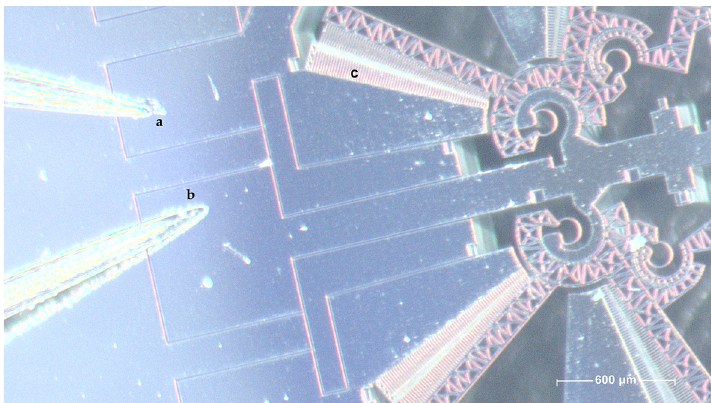
Figure 2. The two micropositioners with probe arms and tungsten needles ( a ) and ( b ), used in both the experimental setups; a voltage is applied to the comb-drive ( c ) of the DUT, in order to supply the device. Two micropositioners with 5 µ m resolution have been used, each one being equipped with tungsten needles, in order to apply the voltage to the DUT electrodes, Figure 3, and a set of digital images have been acquired using a Fogale Zoomsurf 3D OPS. The digital image resolution of 0.6 pixel/ µ m is provided by the Profilometer embedded software.